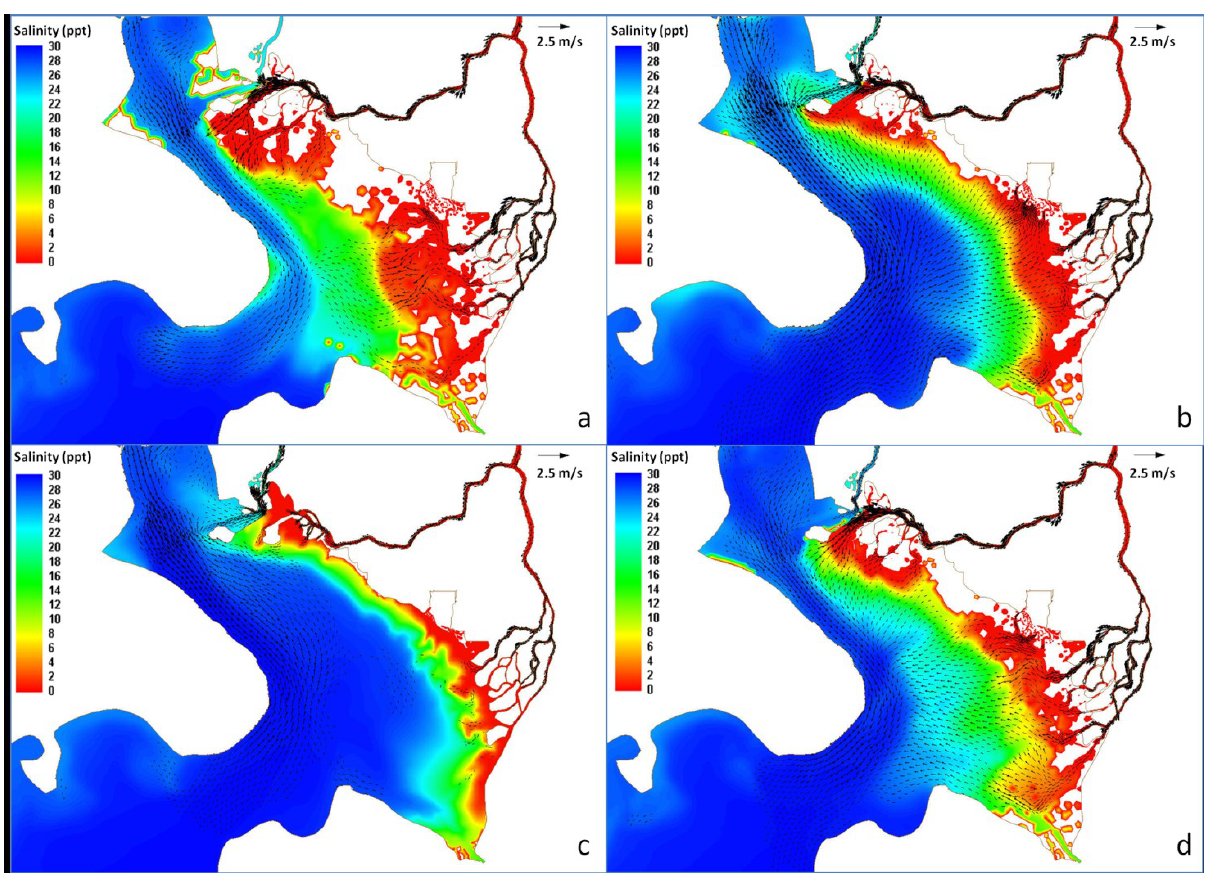
Figure 5. Instantaneous depth-average velocity and salinity at low tide ( a ); flood tide ( b ); high tide ( c ); and ebb tide ( d ) in Skagit River estuary under baseline